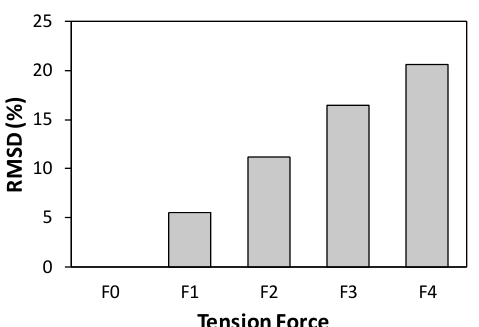
Figure 12. Monitoring of tension force changes in axial cylindrical member using root mean square deviation (RMSD) index.